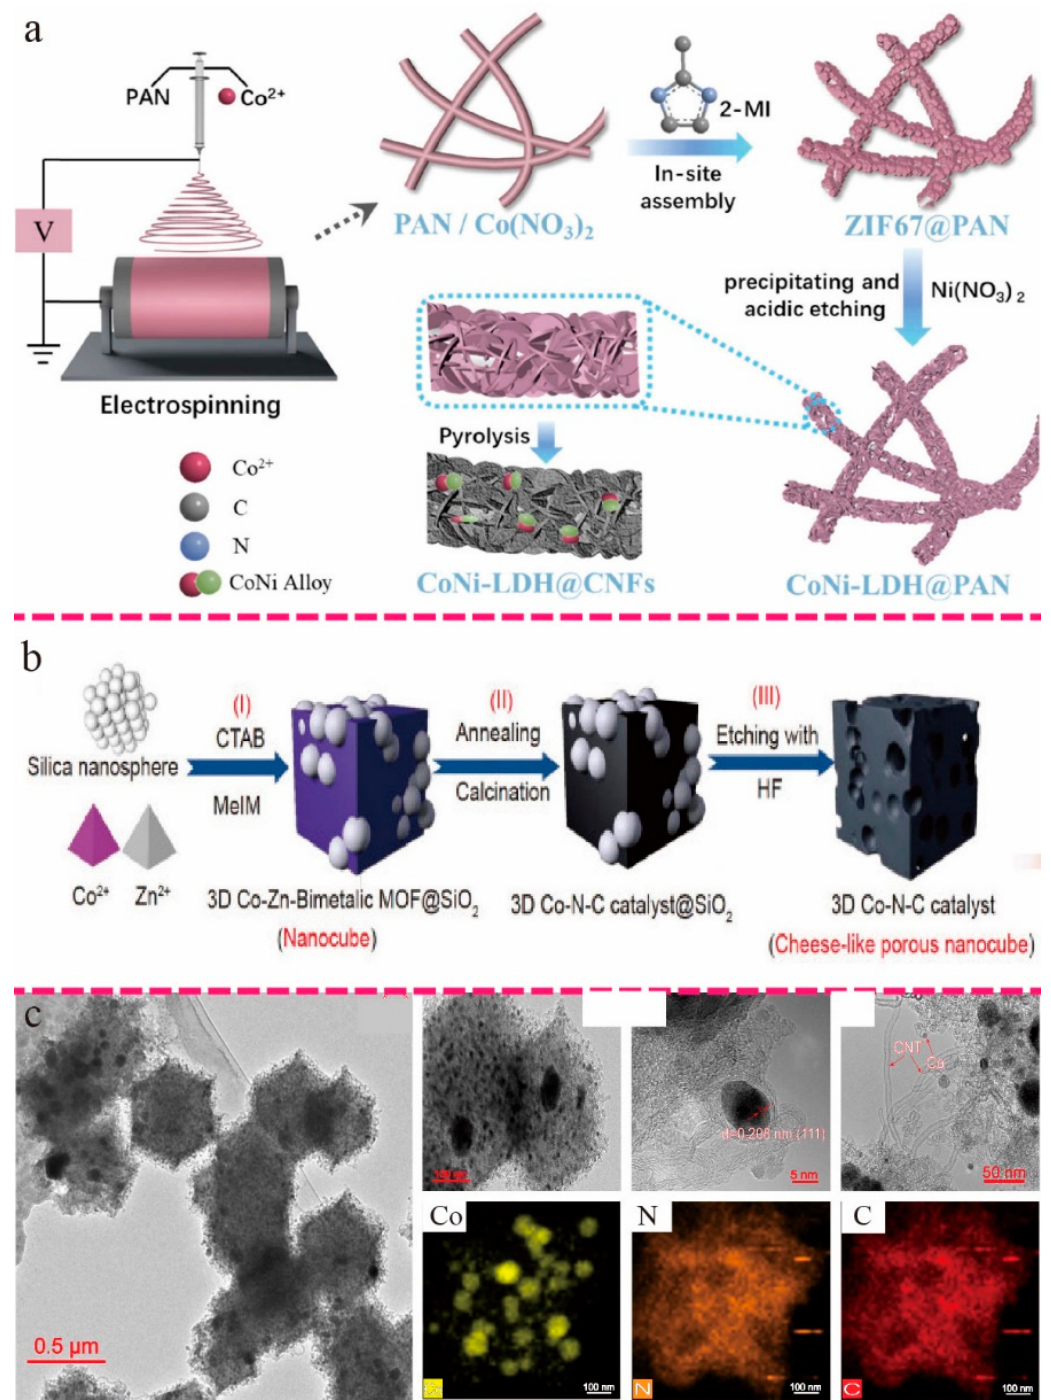
Figure 2. ( a ) Schematic illustration of CoNi-LDH@CNFs synthesis [47]. Copyright 2022, Elsevier. ( b ) Three-dimensional hierarchically porous Co-N-C skeleton synthesis diagram [54]. Copyright 2021, Springer. ( c ) FESEM images of ZnCo-ZIFs-derived Co-NCNTNP and elemental mappings of Co, N, and C in Co-NCNTNP [51]. Copyright 2019, Elsevier.